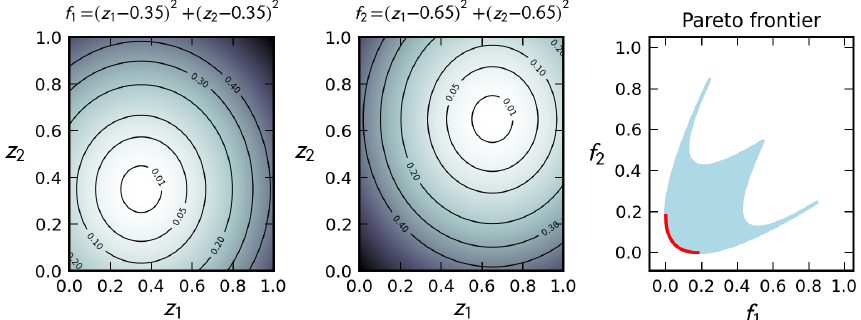
Figure 3. The figures illustrate the simple multiobjective problem described in Sect. 4.1. The figures on the left and in the middle show contours and shadings of the two quadratic objective functions f 1 and f 2 as a function of design variables z 1 and z 2 (low and high values are indicated by light and dark shades, respectively). The figure on the right shows non-optimal solutions (light blue shaded region) and optimal points along the Pareto frontier (red line) for the problem given in Eq.